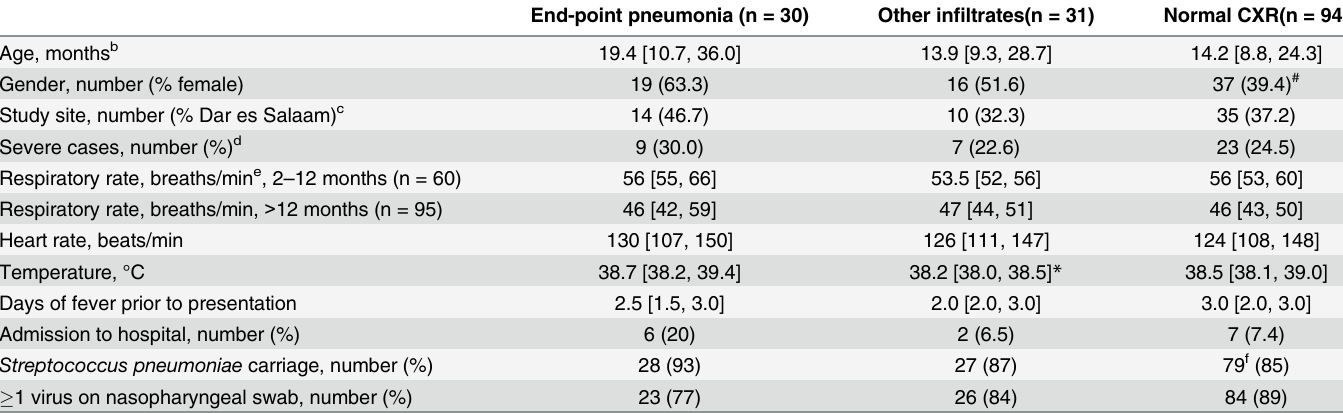
Table 1. Demographic and clinical characteristics of study participants with WHO-defined clinical pneumonia, categorized by radiological findings.